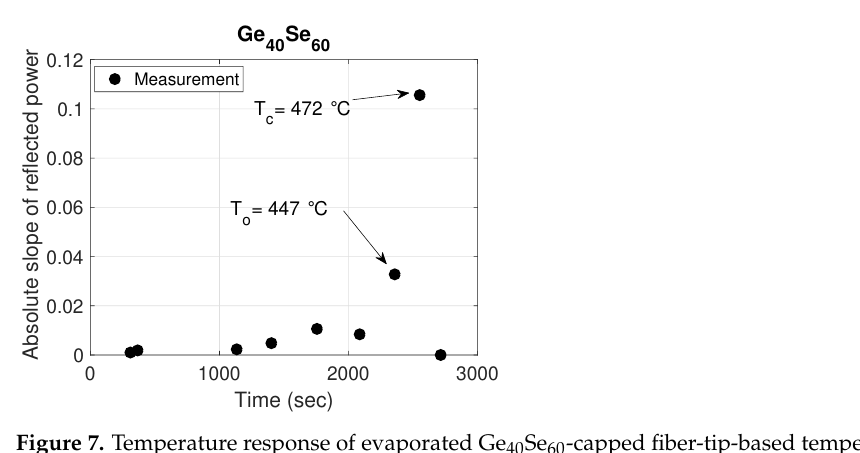
Figure 6. Simulated and measured normalized reflected power as a function of time with Ge 30 S 70 - capped fiber tip.